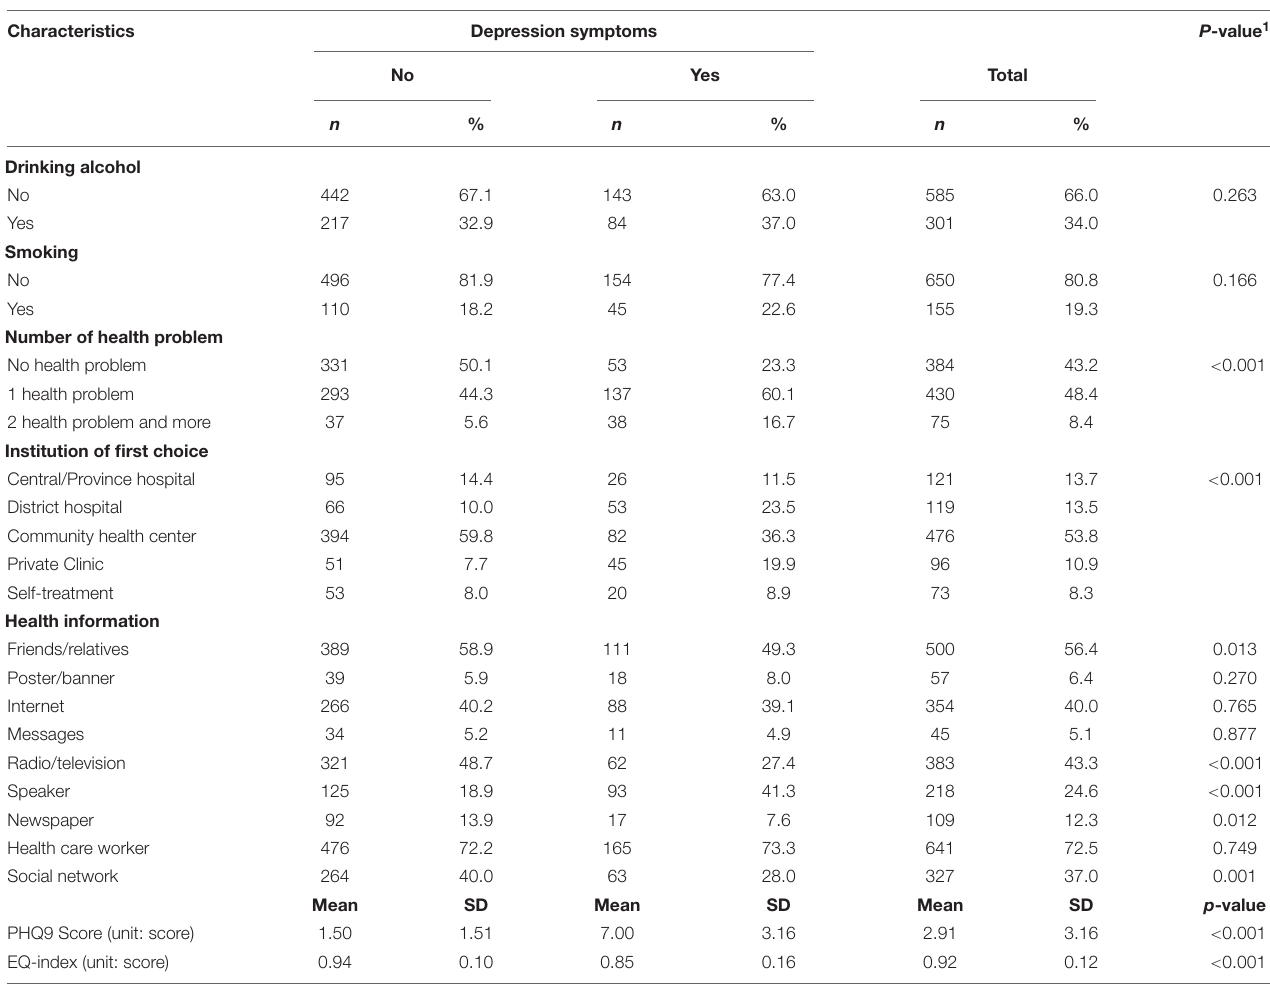
TABLE 2 | Health status and risk behaviors of respondents.